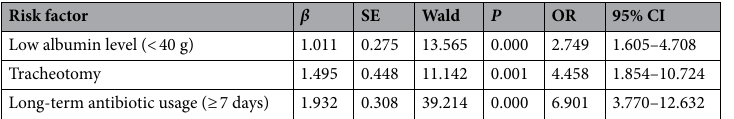
Table 5. Multifactorial logistic analysis of risk factors for MDRO-related infection